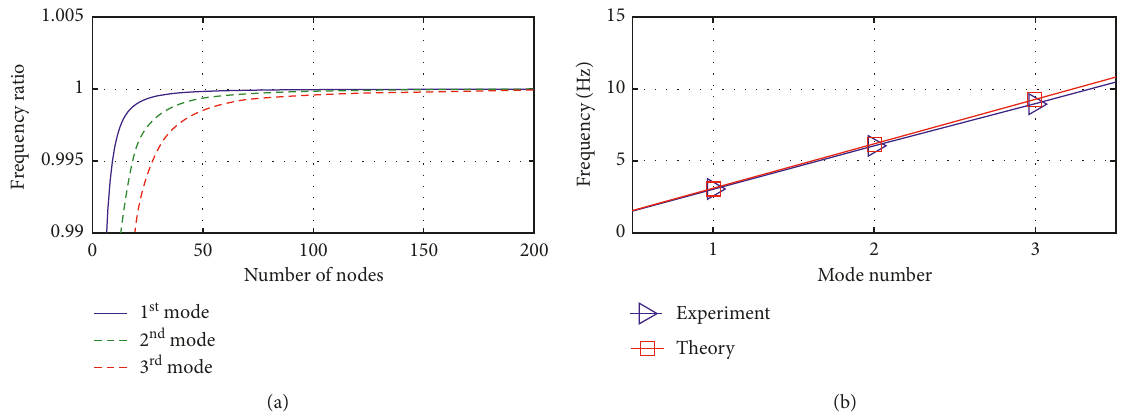
Figure 4: (a) Frequency ratios for the first three modes; (b) comparison of the natural frequencies with n � 200 to the experimental results.